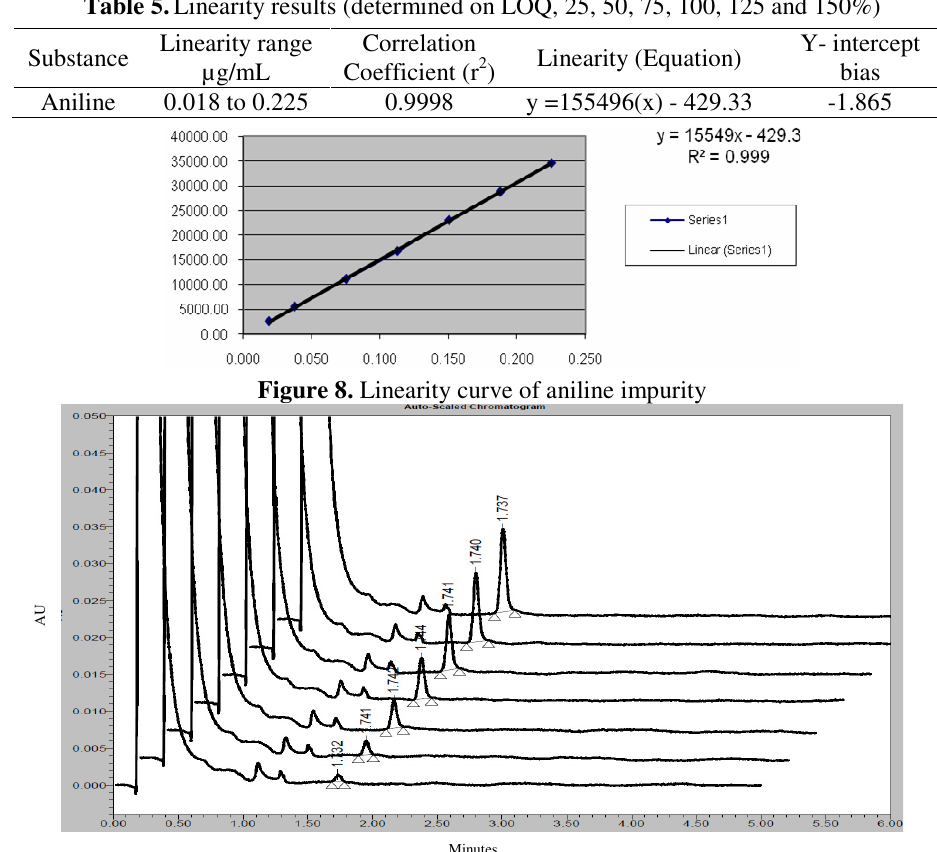
Figure 9. Overlay chromatograms of aniline linearity (LOQ to